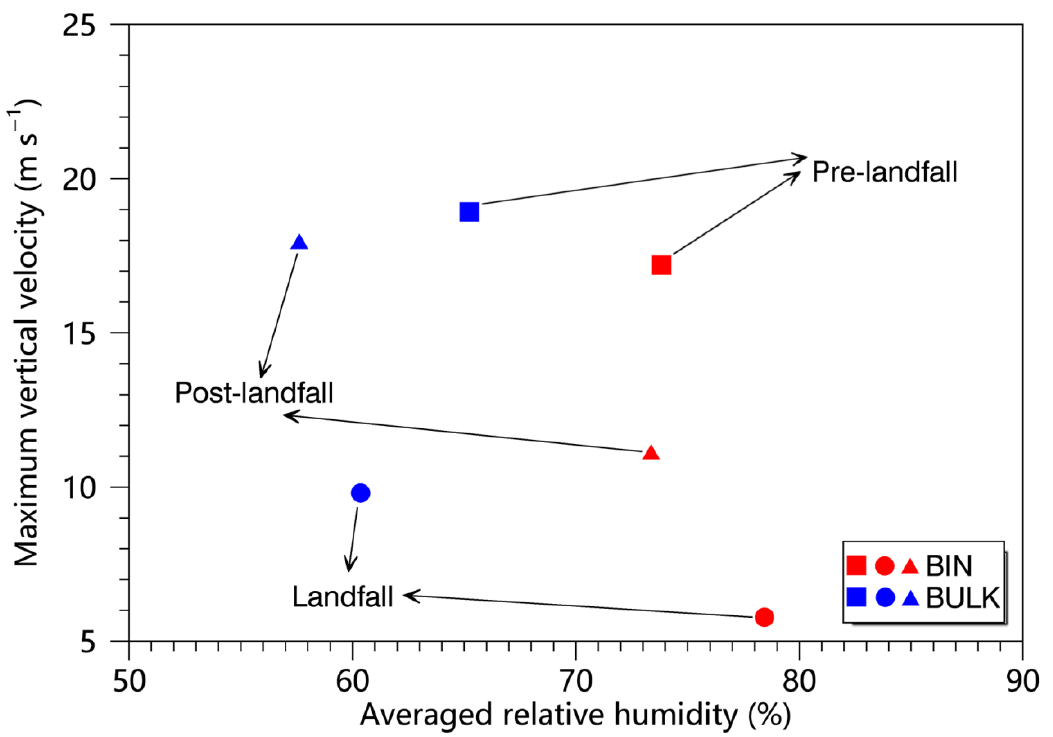
Figure 10. The maximum vertical velocity (m s −1 ) versus averaged relative humidity (%) from WRF simulations using BIN and BULK schemes. The square symbols represent pre-landfall stage, the circle symbols represent landfall stage, and the triangle symbols represent post-landfall stage.